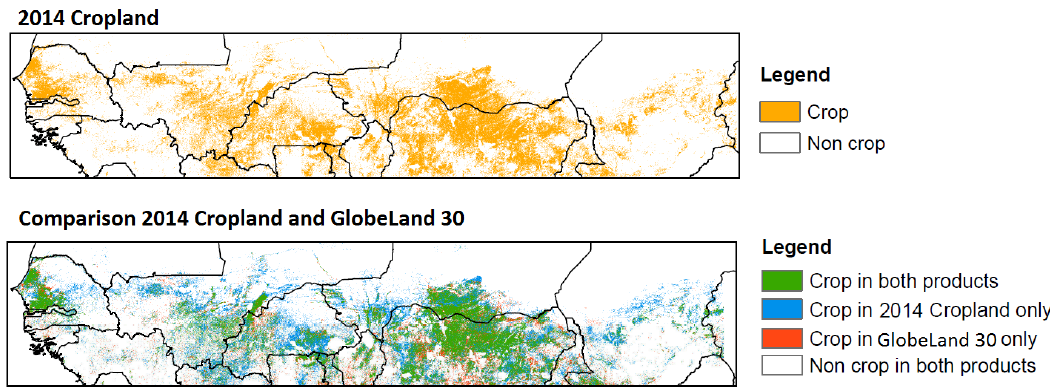
Figure 14. The 2014 Sudano-Sahelian Cropland map derived from PROBA-V at 100-m and the comparison with GlobeLand 30 derived from Landsat imagery acquired around